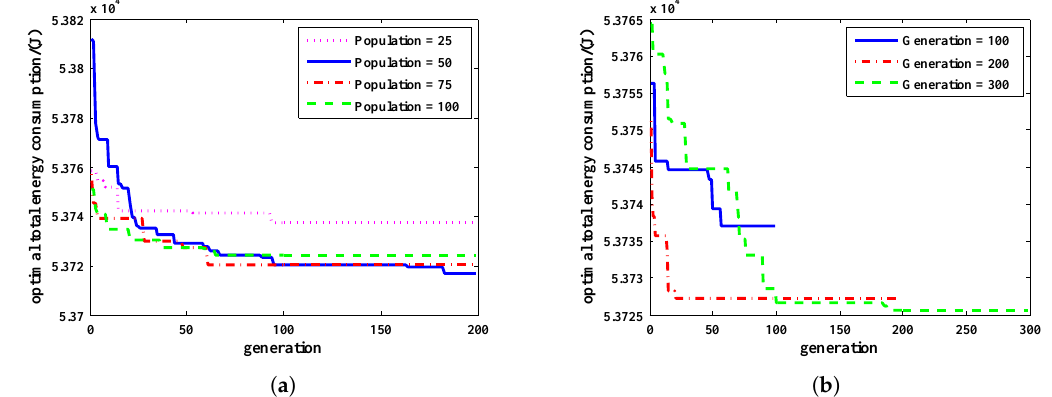
Figure 18. The optimal result of different optimal parameters. Panel ( a ) shows the optimal result of different populations and ( b ) shows the optimal result of different generations. Table 10. Optimization time of different optimal parameters.